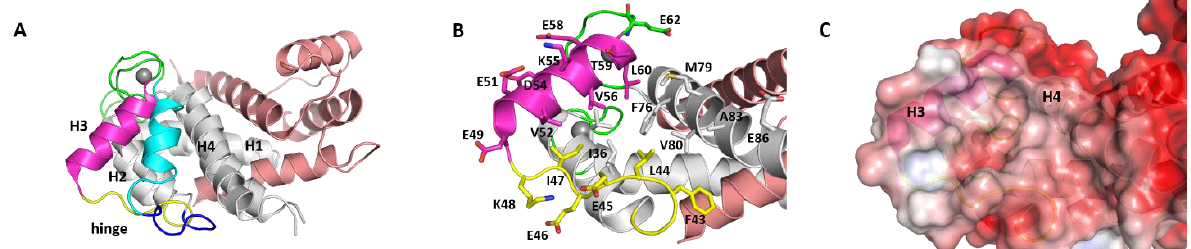
Figure 1. Structures of S100B(ββ). ( A ) Cartoon representation of superimposed apo and calcium bound conformations of the S100B(ββ) protein. Each monomer in the dimer is coloured separately (monomer 1: grey, monomer2: salmon) with H2 and hinge in monomer 1 in its apo (cyan, blue) and calcium bound (magenta, yellow) states, hinge regions (green) and bound calcium (grey sphere) are highlighted. ( B ) The residues from the hydrophobic pocket are highlighted in sticks with colouring similar to ( A ). ( C ) Electrostatics surface representation (red to blue colours represent electrostatic potentials ranging from −5 to +5 kcal/mol) of the calcium bound S100B(ββ) protein dimer; the grey/white colour is localized to the hydrophobic pocket.